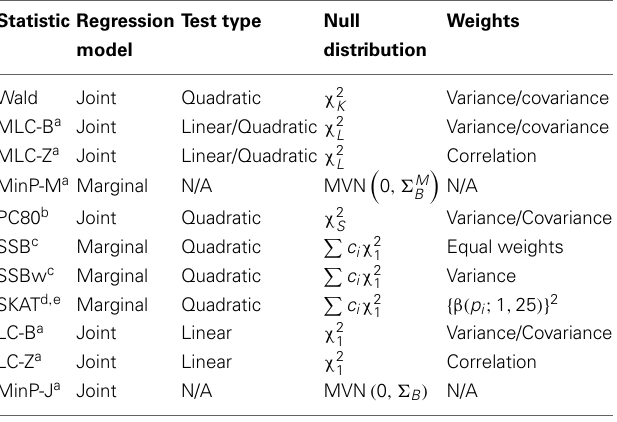
Table 1 | Description of multi-marker statistics investigated in this